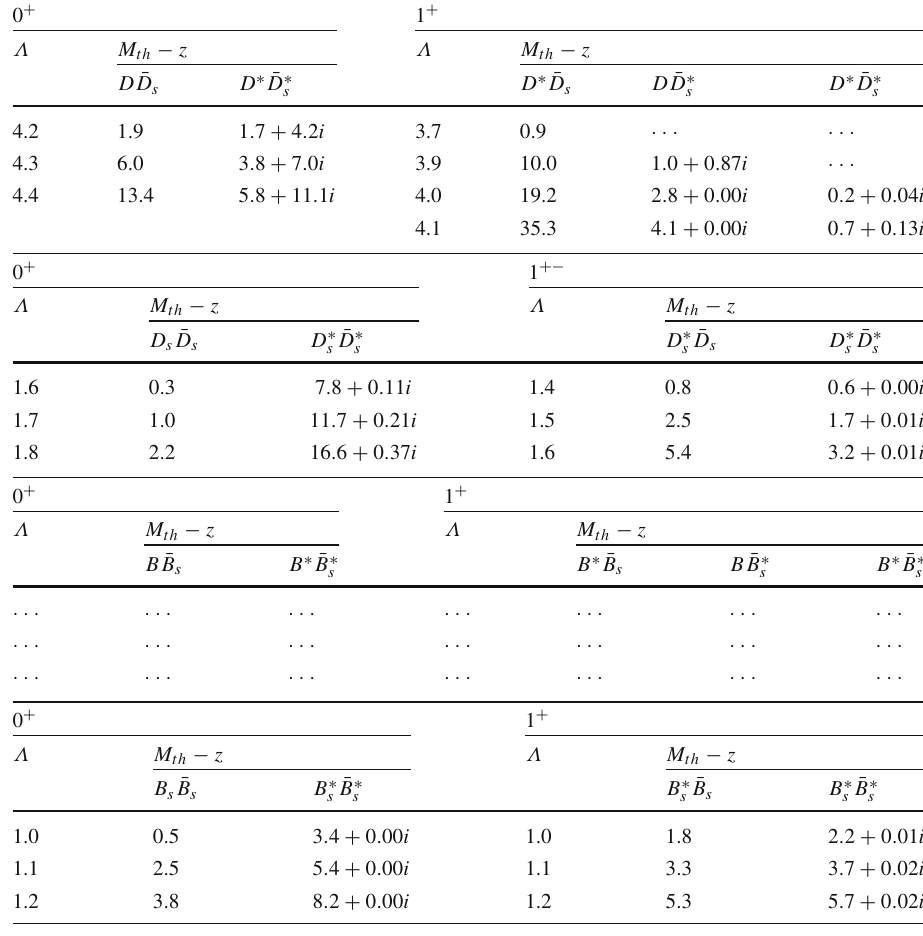
Table 7 The M th − z of the poles from the hidden-heavy coupled-channel interaction. The cutoff Λ and position of the pole z are in units of GeV and MeV,